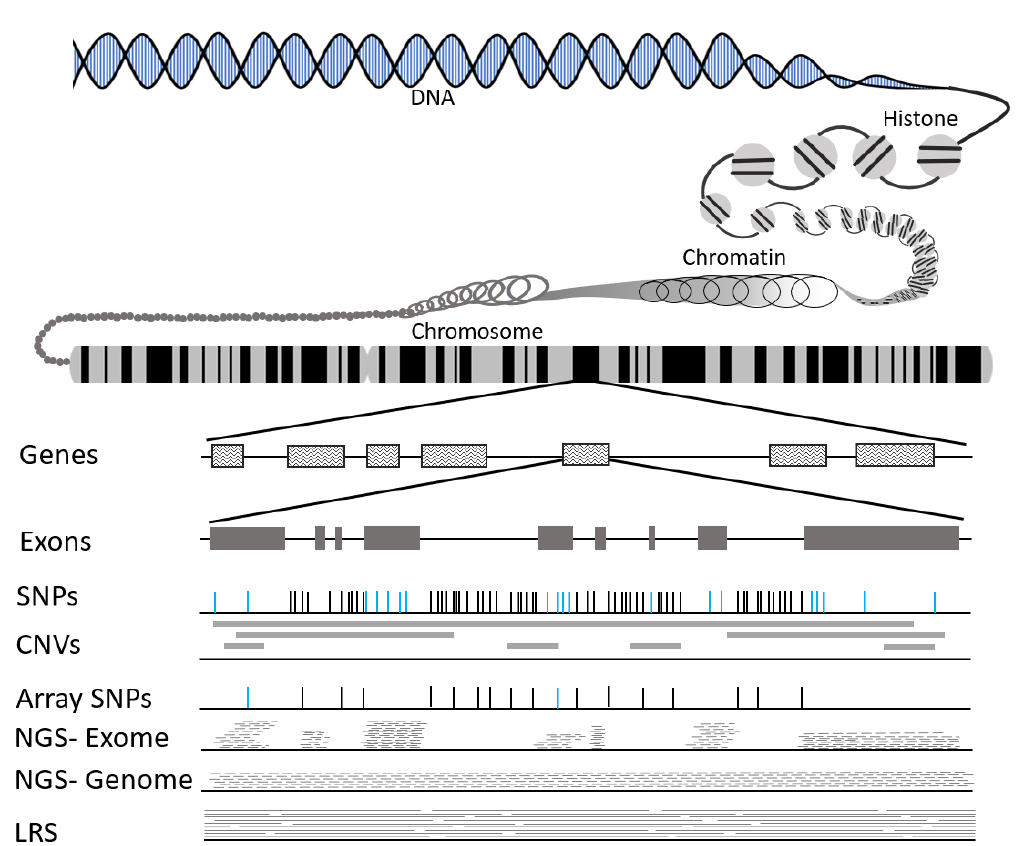
Figure 1. Illustration of DNA organization, types of variation present, and capture of variants using differing technologies.